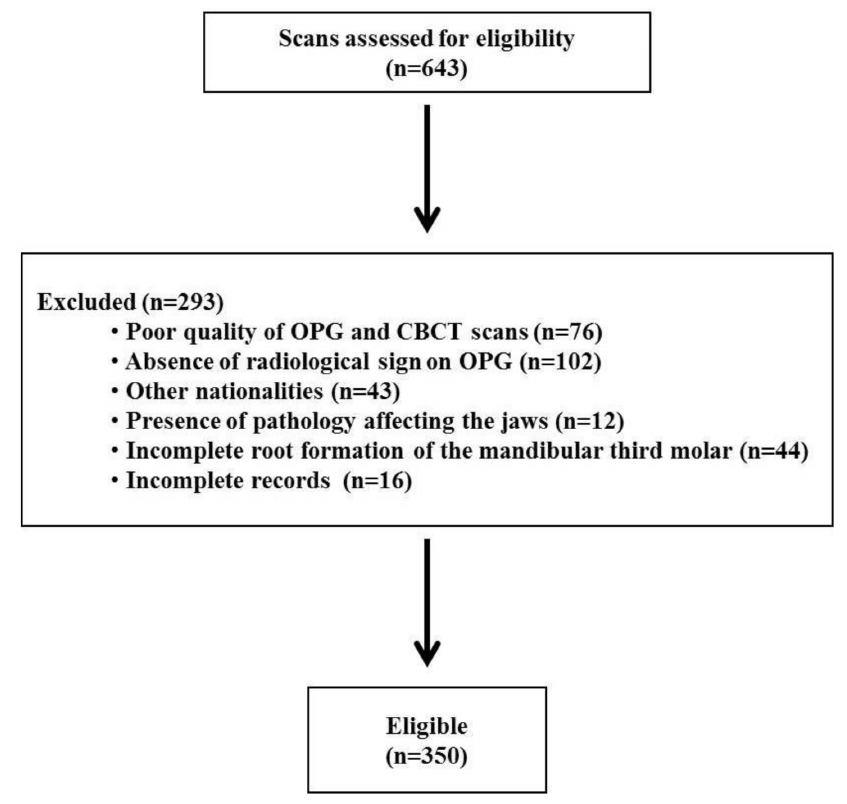
Figure 1. Flow chart of study